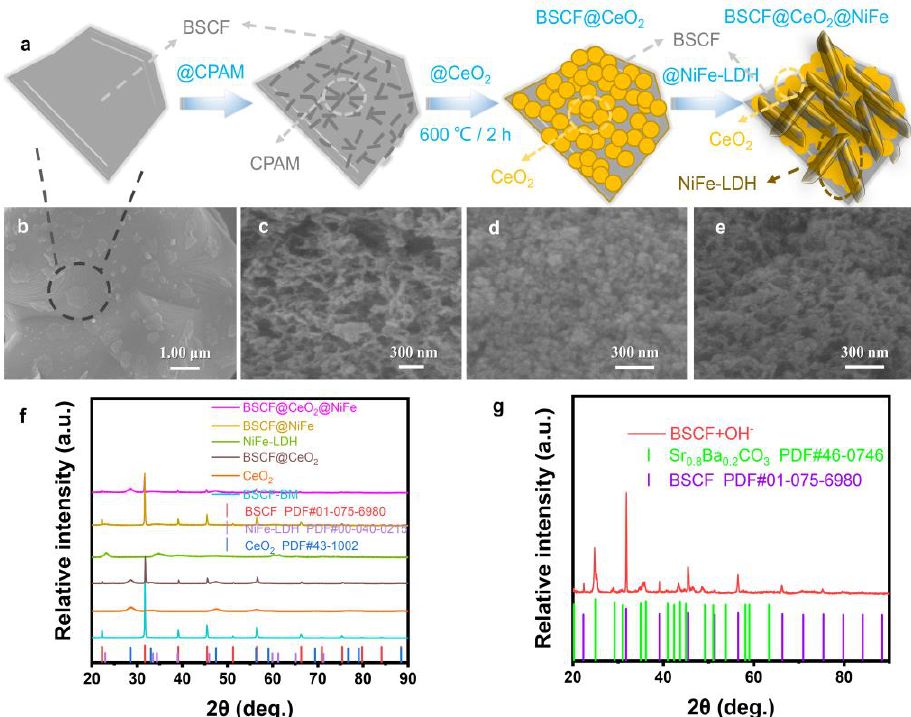
Figure 1. ( a ) Schematics of the preparation of BSCF@CeO 2 @NiFe. SEM images of BSCF ( b ),